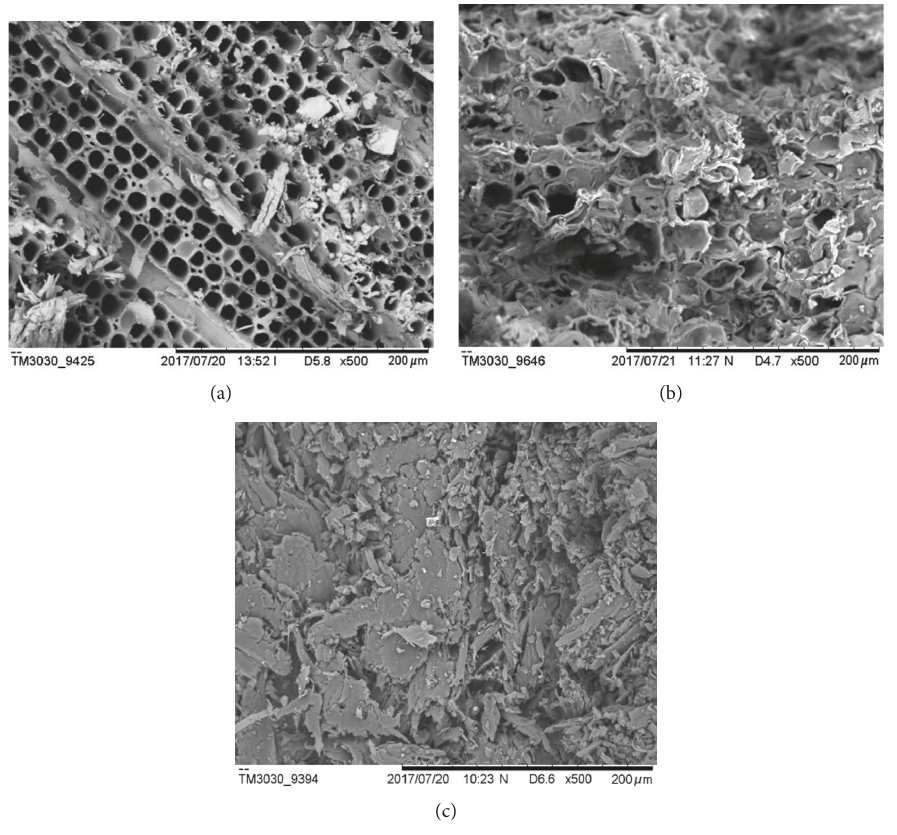
Figure 4: SEM images for RW (a), WPC (b), and WPNC